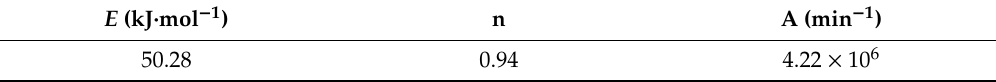
Table 3. Kinetic parameters determined by fitting nonisothermal DSC